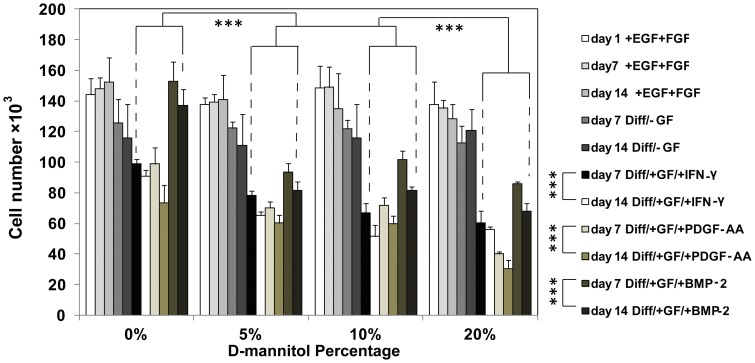
Total cell number at day 7 and 14 for porous scaffolds cultured in control (+EGF+FGF, -GF) and differentiation (INF-γ, PDGF-AA, BMP-2) media.NSPCs were initially seeded at 200 × 103 cells/scaffold. *** denotes significance by two-factor ANOVA (p<0.0001). Mean ± SD with n = 3. All scaffolds were cultured for 1 d in expansion media (+EGF+FGF) then switched to conditions labeled in the caption.